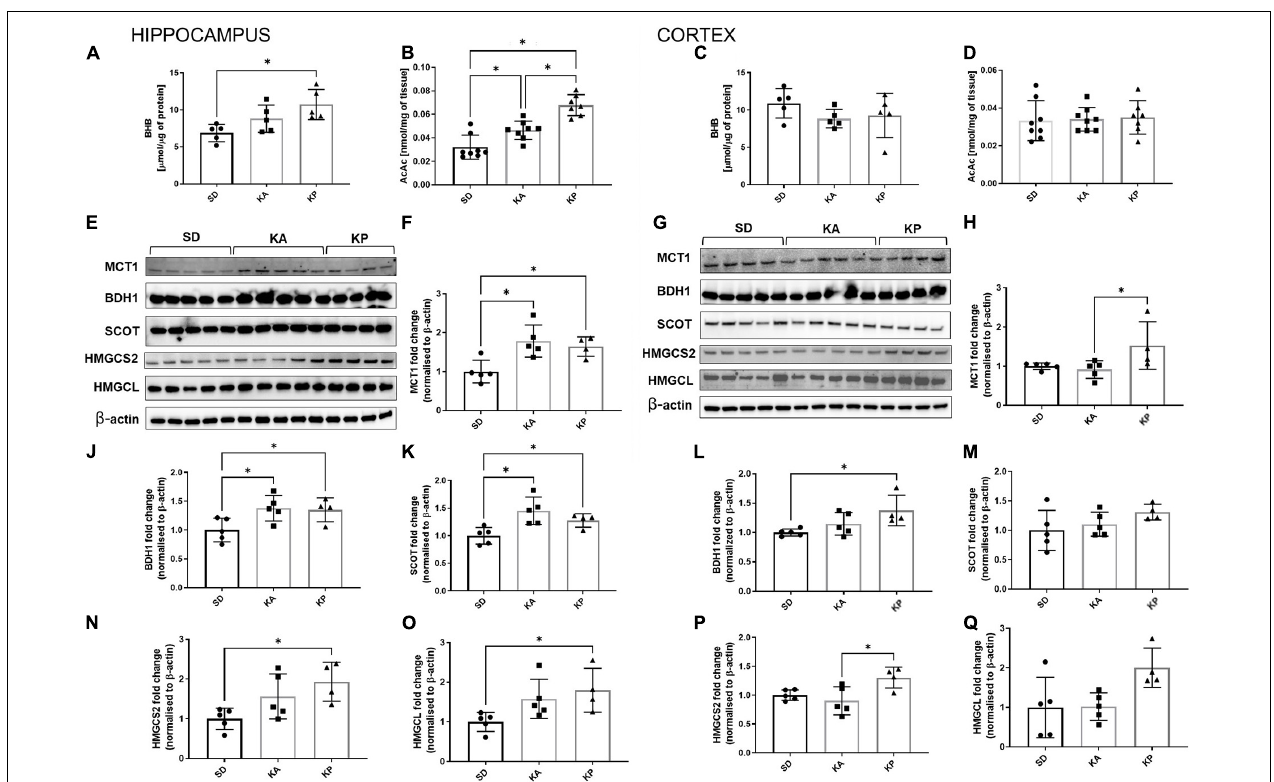
FIGURE 3 | The hippocampal and cortical levels of ketone bodies and enzymes involved in ketone turnover in the cells. The level of hippocampal (A,B , n = 5) and cortical ( C,D , n = 5) β -hydroksybutyrate (BHB) and acetoacetate levels (AcAc). MCT1, BDH1, SCOT, HMGCS2, and HMGCL matched β -actin blots performed in the hippocampus (E) and cortex (G) . Quantification of MCT1 levels in the hippocampus (F) and cortex (H) . Quantification of BDH1 levels in the hippocampus (J) and cortex (L) . Quantification of SCOT levels in the hippocampus (K) and cortex (M) . Quantification of HMGCS2 level in the hippocampus (N) and cortex (P) . Quantification of HMGCL level in the hippocampus (O) and cortex (Q) . The data is presented as a mean ± standard deviation, ∗ indicates statistically significant changes ( p < 0.05). SD marks a group of control animals fed with standard chow, while experimental mice were maintained on the ketogenic diet composed of fat of animal (KA) or plant (KP)